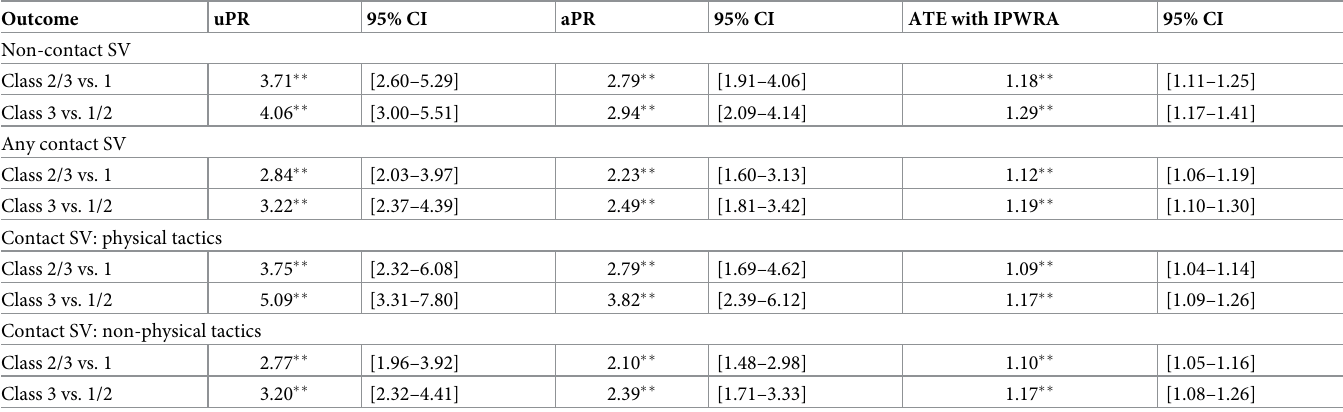
Table 3. Effect of violent sexually explicit material exposure class on sexually violent behavior among first-year university men in Hanoi, Vietnam (n =